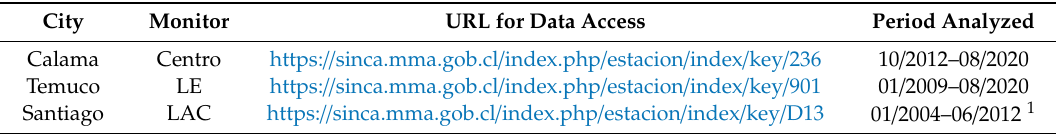
Table 1. Description of ambient monitoring sites analyzed.